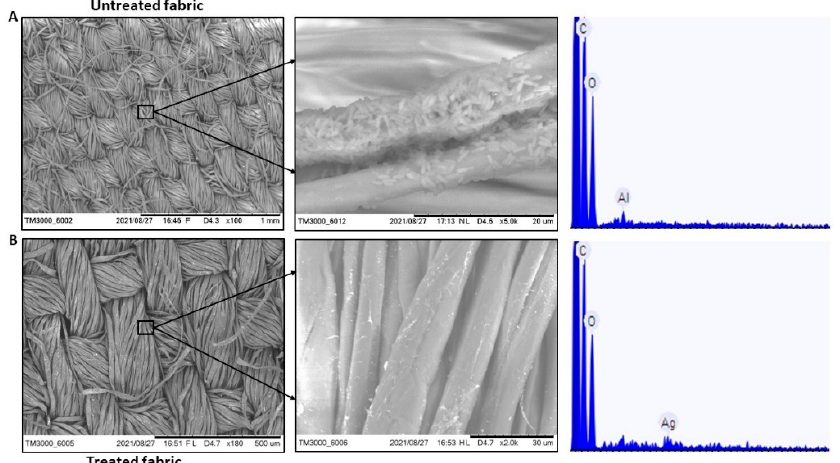
Figure 8. SEM-EDAX images of ( A ). Untreated fabric showing bacterial colonization and absence of Ag on the surface ( B ). Treated fabric showing no bacterial colonization and presence of AgNP on the surface. (EDAX value: 0.139 atomic%, acquisition time 60 s, accelerating voltage 15.0 kV, image width 316.0 µm).